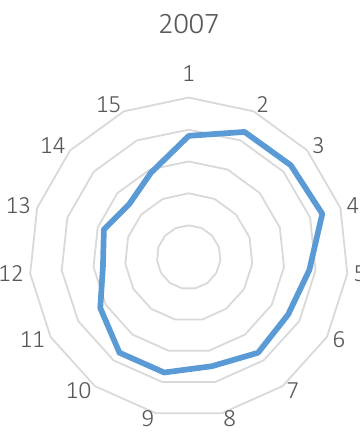
Figure 1. Radial chart of changes in CSR objectives